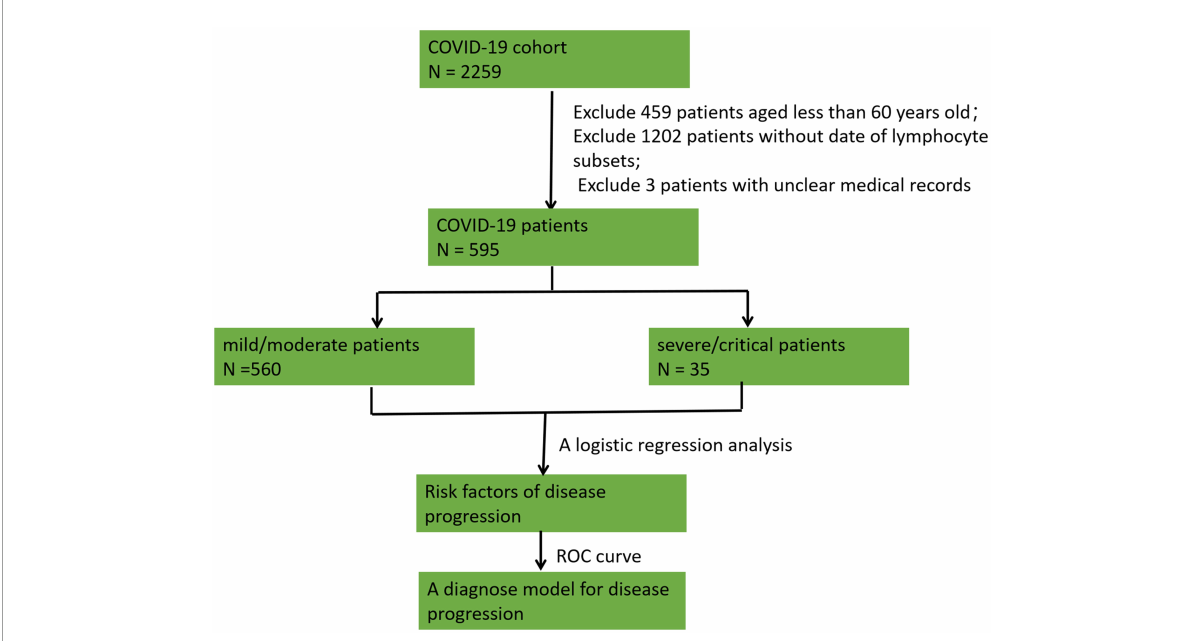
FIGURE1 A flow chart of patient enrollment and exclusion and the study design. A total of 2,259 patients with COVID-19 infection were considered. We excluded 459 patients aged < 60 years, 1,202 patients without lymphocyte subset data, and 3 participants with unclear medical records. Overall, 595 patients were enrolled in the study. The patients were divided into a mild/moderate group and a severe/critical group, and a logistic regression analysis was conducted to analyze risk factors for disease progression. Receiver operating characteristic (ROC) curves were constructed to explore the ability to discriminate severe/critical patients from mild/moderate